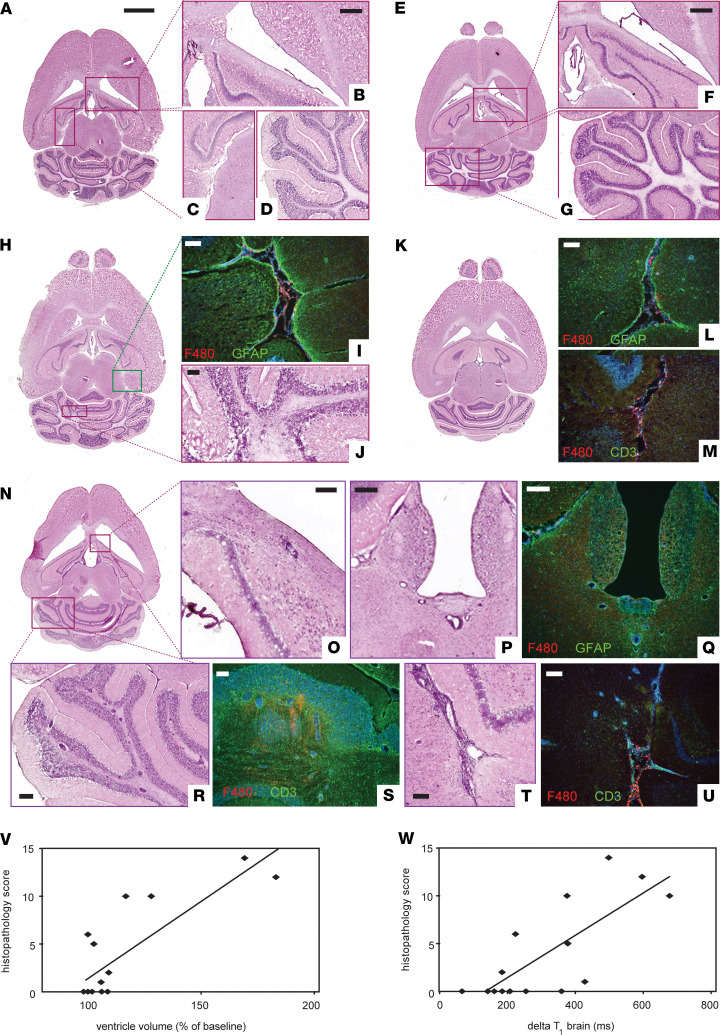
Early ventricle enlargement in EAE correlates with inflammation.(A–G) Representative images of H&E-stained tissue sections show absence of pathology at baseline (A–D) and day 3 p.i. (E–G). Higher magnifications views show periventricular (B and F), meningeal (C), and cerebellar regions (D and G). (H–J) First signs of pathology were detected on day 5 p.i., as infiltration of macrophage/myeloid cells (F4/80+, red) and accompanying gliosis (GFAP, green) in meningeal areas (I) and inflammatory foci in cerebellar white matter (J). (K–M) By day 8 p.i., pronounced meningeal infiltration and gliosis was present (L), along with T cell infiltration in the parenchyma (CD3+, green) (M). (N) At day 11 p.i., ventricular enlargement was grossly apparent from the whole brain tissue sections. (O–U) Extensive inflammation was seen throughout the brain, including periventricular regions (O, P, Q), cerebellum (R, S), and meningeal areas (T, U), along with gliosis (Q) and infiltration of F4/80 and CD3 positive cells (Q, S, U). (V and W) Semiquantitative scoring of histopathology (n = 19) correlated positively with ventricle volume changes (V) and gadolinium enhancement as ΔT1 changes in whole brain (W) (Spearman’s r). Scale bars: A (whole brain images): 2 mm; B–D, F, and G: 500 μm; P–R: 200 μm; I and J, L and M, O, and S–U: 100 μm.